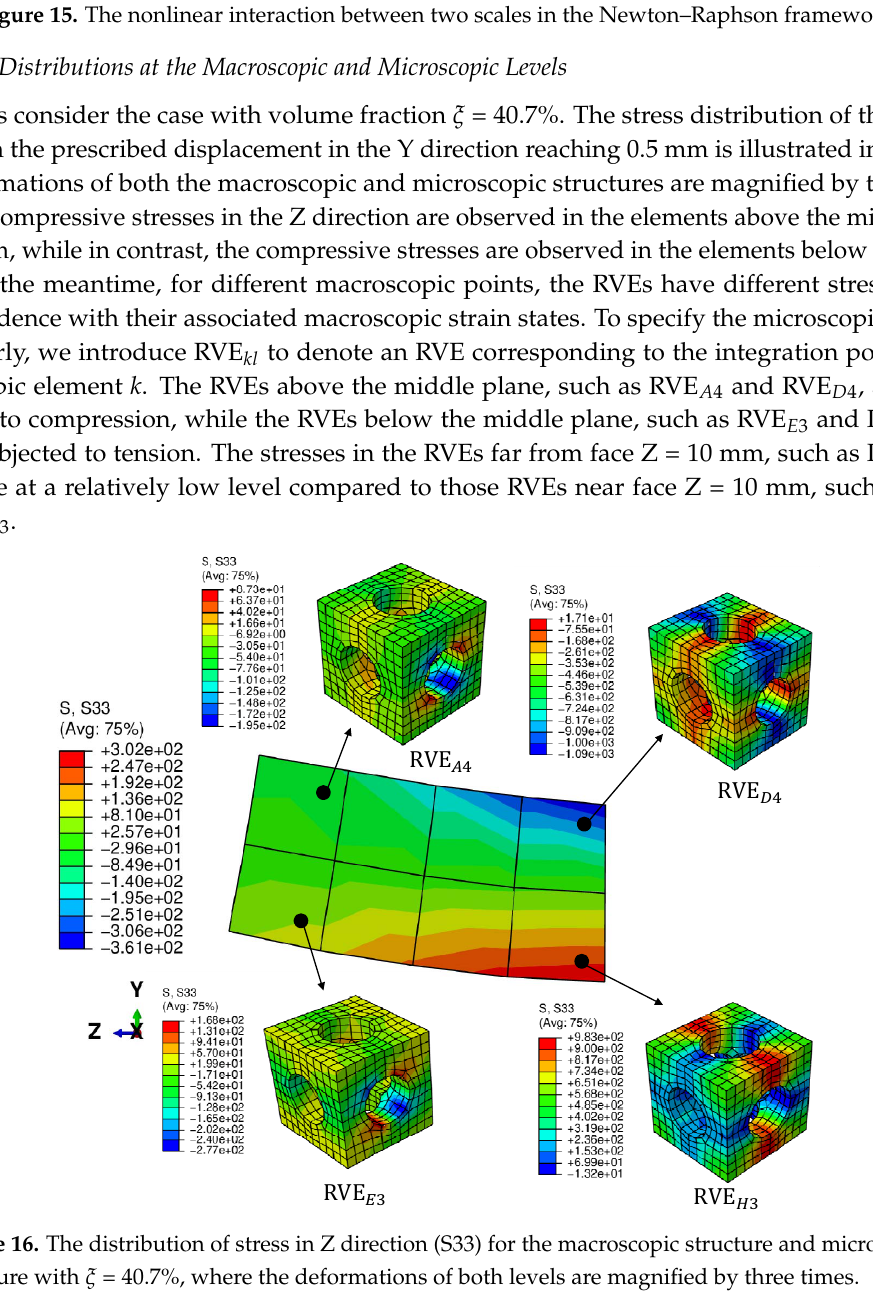
Figure 15. The nonlinear interaction between two scales in the Newton–Raphson framework.